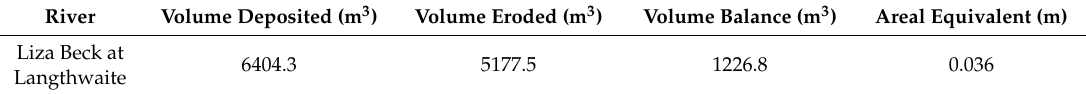
Table 2. Reach extreme event gross sediment budget for the Liza Beck at